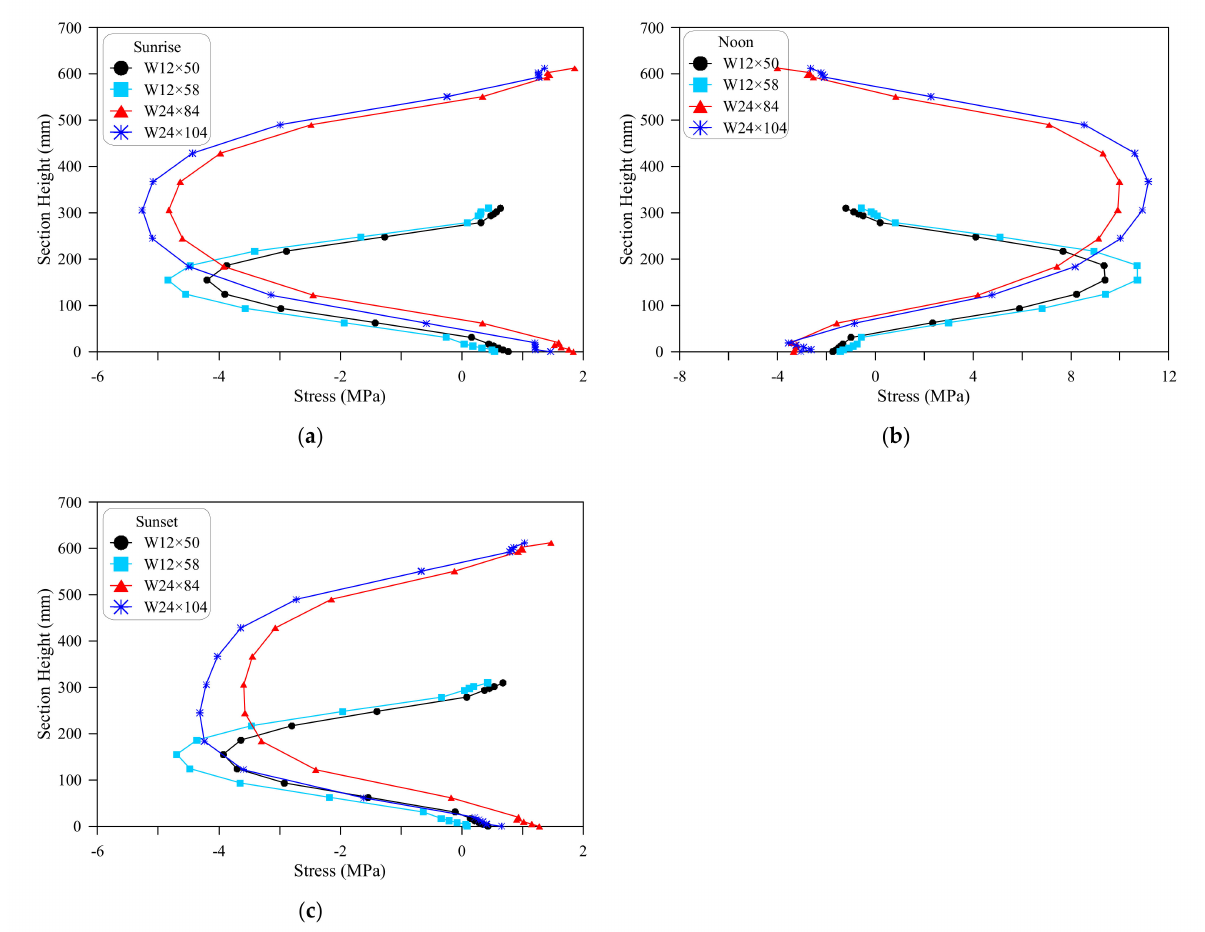
Figure 16. Thermal stresses of the four sections: ( a ) At sunrise; ( b ) At noon; ( c ) At